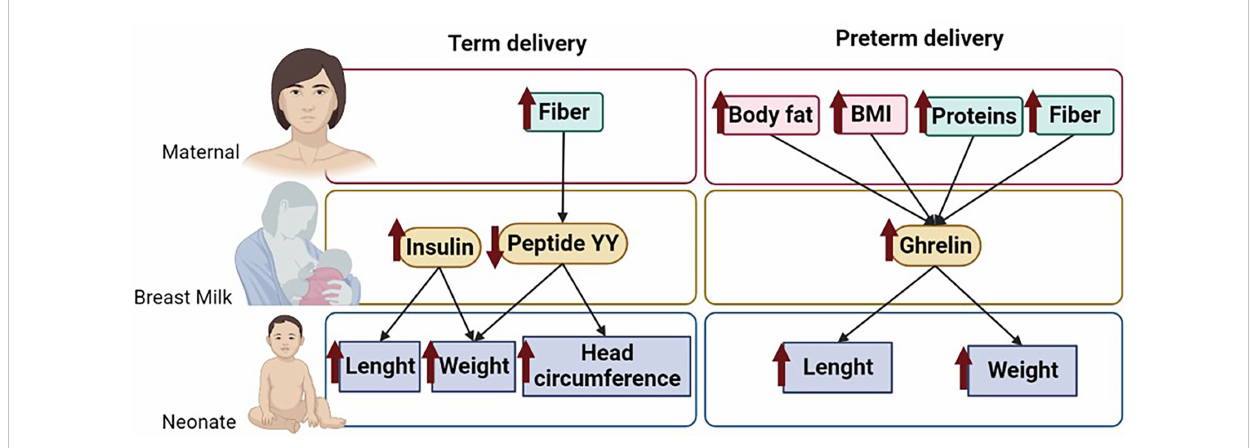
FIGURE 6 Summary of the main results of the study. Figure shows the maternal dietary components and body composition parameters that in fl uence BM hormone levels and their association on neonatal growth. The arrows indicate associations between parameters.